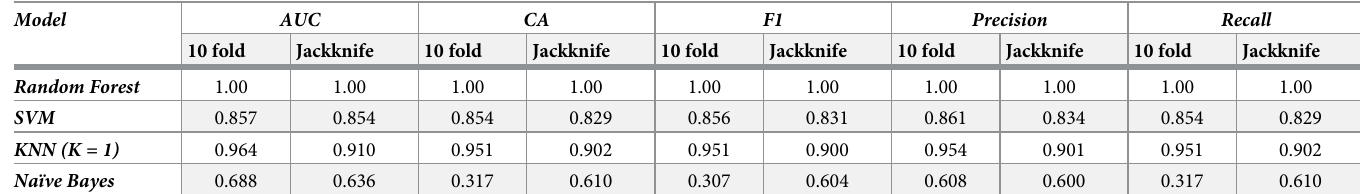
Table 2. Results from three different